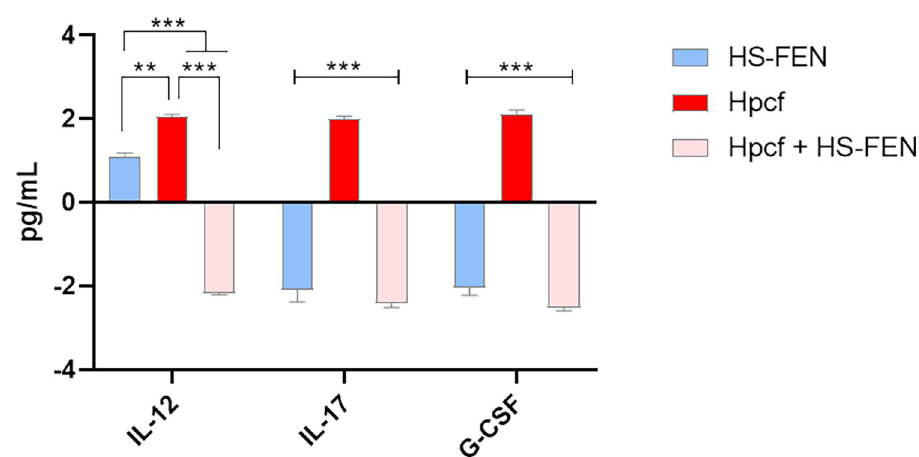
Fig 8. HS-FEN mitigates Hpcf-induced inflammation. Expression level of cytokines IL-12, IL-17 and G-CSF detected in AGS culture medium. Graph reports pg of cytokine in mL of cell medium differently treated: 1) HS-FEN 25 μ g mL -1 ; 2) Hpcf 1:2 for 12 hours; 3) Hpcf 1:2 + HS-FEN 25 μ g mL -1 for 12 hours. Values were normalized to basal activity (control cells) and data were represented as means ± s.d. of three independent experiments, each performed in triplicate. One-way ANOVA followed by Bonferroni post hoc correction was used to determinate statistically significant differences ( �� p < 0.001; ��� p < 0.0001).